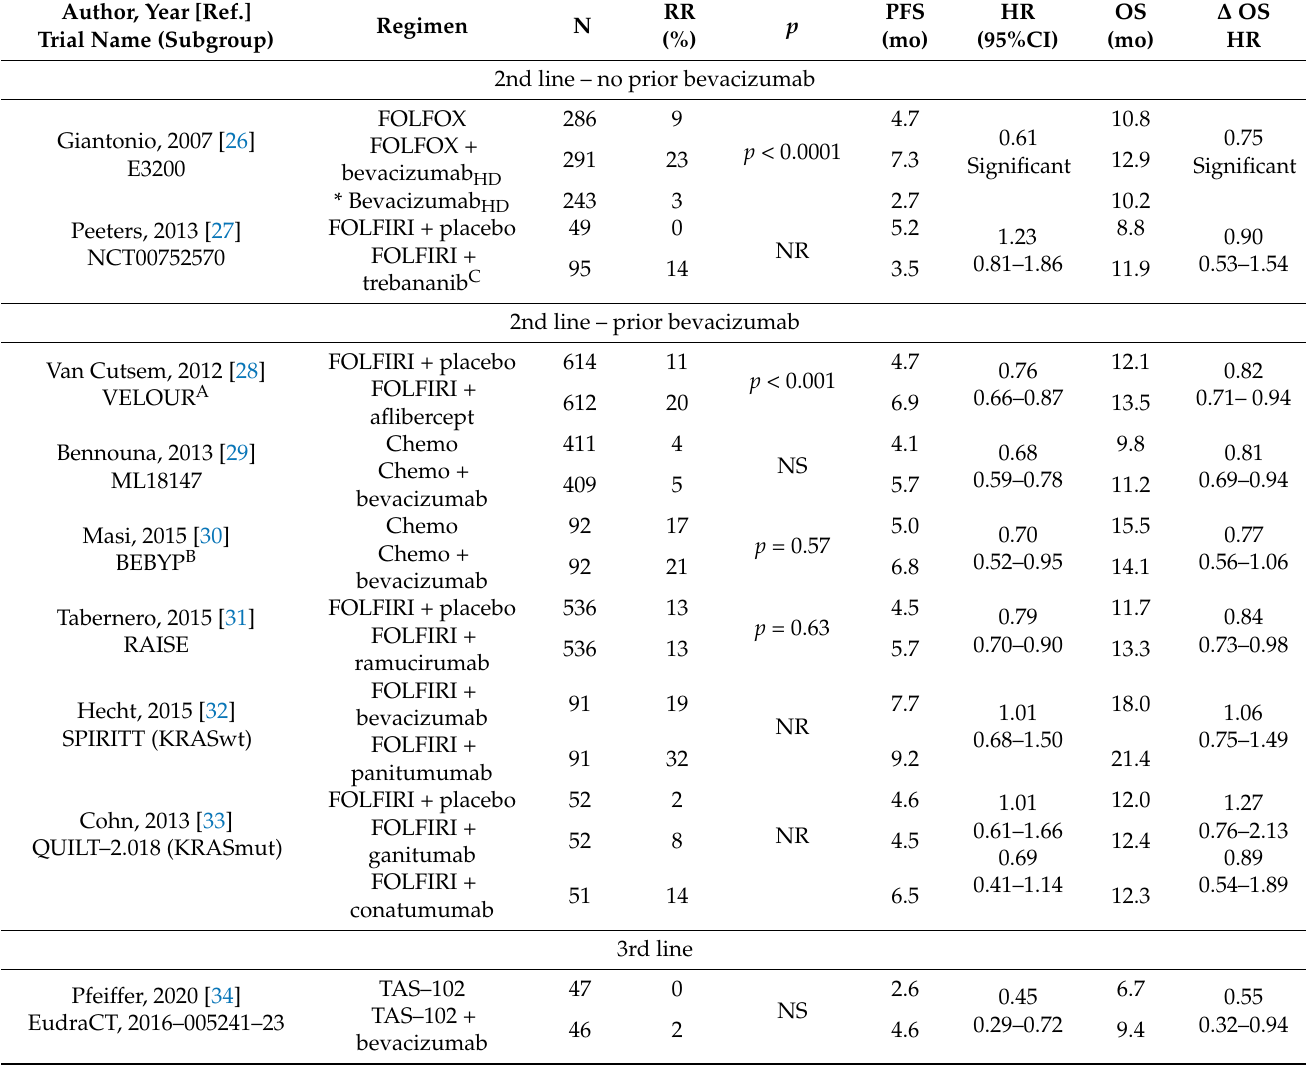
Table 2. Principal randomized trials comparing second or later line chemotherapy with anti-angiogenic therapy in unselected patients with